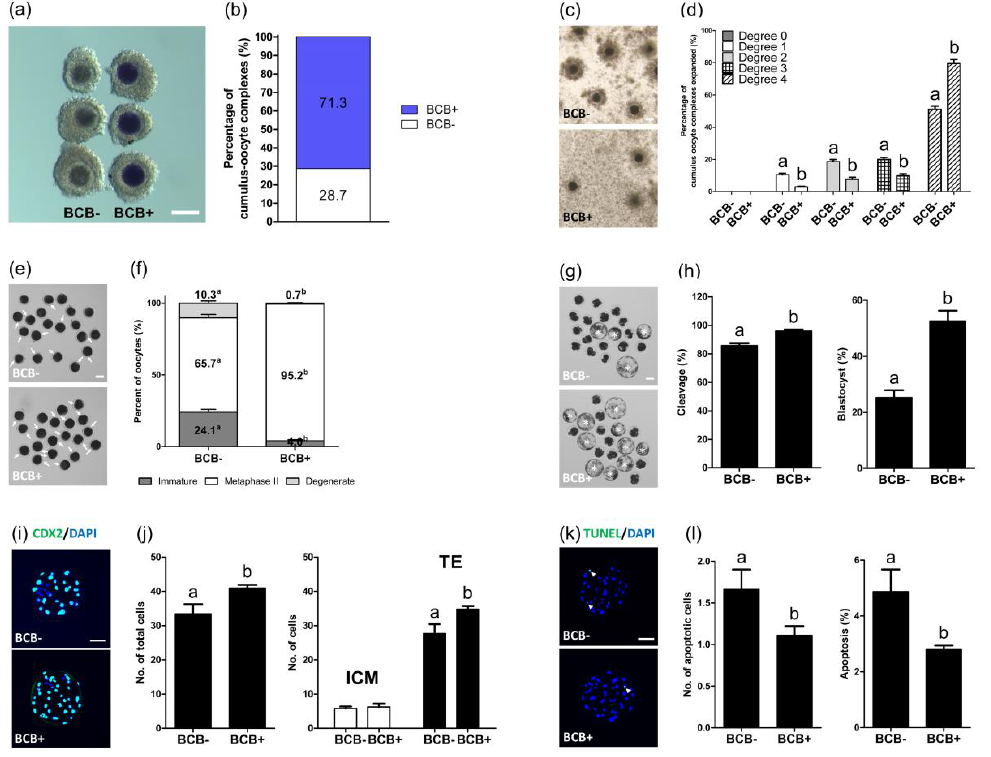
Figure 1. Comparison of brilliant cresyl blue (BCB-) and BCB + cumulus-oocyte complexes (COCs) in terms of cumulus expansion, nuclear maturation, and subsequent embryo development after parthenogenetic activation. ( a ) Representative photomicrographs of germinal vesicle-stage porcine COCs after BCB staining. The colorless ooplasm indicates BCB- COCs, and the blue ooplasm indicates BCB + COCs. ( b ) The ratio of BCB- to BCB + COCs after staining. ( c ) Representative photomicrographs, and ( d ) the percentage of the degree of the cumulus expansion of BCB- and BCB+ COCs, after 44 h of IVM. ( e ) Representative photomicrograph of in vitro matured oocytes, and ( f ) the percentage of different stages of nuclear maturation in BCB- and BCB+ oocytes, after 44 h of IVM. The white arrows indicate in vitro matured oocytes with a first polar body. ( g ) Representative photomicrographs of blastocysts (white asterisks), and ( h ) the cleavage and blastocyst formation rates of embryos developed from BCB- and BCB+ oocytes. ( i ) Immunocytochemistry of CDX2/ 4′,6 -diamidino-2-phenylindole (DAPI) using blastocysts developed from the indicated groups. Merged images of CDX2 (green) and DAPI (blue) signals are shown. ( j ) Quantification of the total, inner cell mass (ICM), and trophectoderm (TE) cell numbers in the indicated groups. ( k ) Terminal deoxynucleotidyl transferase mediated dUTP digoxygenin nick end labeling (TUNEL) assay using blastocysts developed from the indicated groups. Merged images (light green) of TUNEL (green, white arrowheads) and DAPI (blue) signals are shown. ( l ) Quantification of the numbers and proportion of apoptotic cells in the indicated groups. Within each category, groups marked with different letters (a and b) are significantly different ( p < 0.05). Bar = 100 μM.